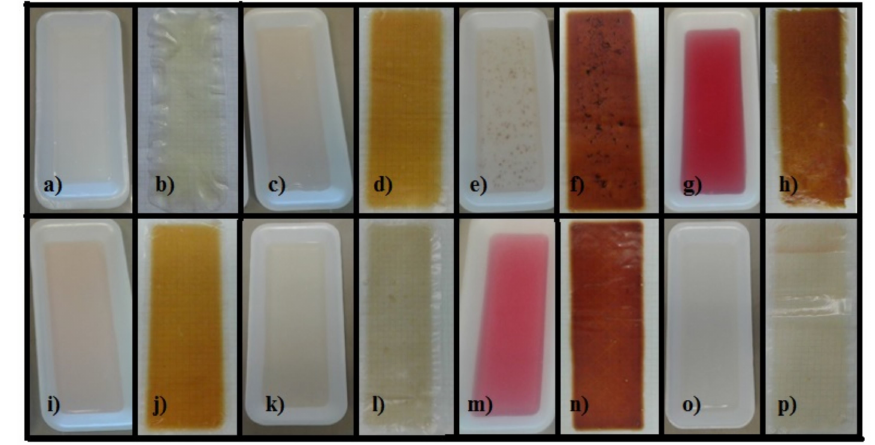
Figure 1. Coloration of films 15: ( a ) QS2 day 1; ( b ) QS2 day 15; ( c ) QSA2 day 1; ( d ) QSA2 day 15; ( e ) QSAm2 day 1; ( f ) QSAm2 day 15; ( g ) QSB2 day 1; ( h ) QSB2 day 15; ( i ) QSG2 day 1; ( j ) QSG2 day 15; ( k ) QSO2 day 1; ( l ) QSO2 day 15; ( m ) QSP2 day 1; ( n ) QSP2 day 15; ( o ) QSR2 day 1; and ( p ) QSR2 day